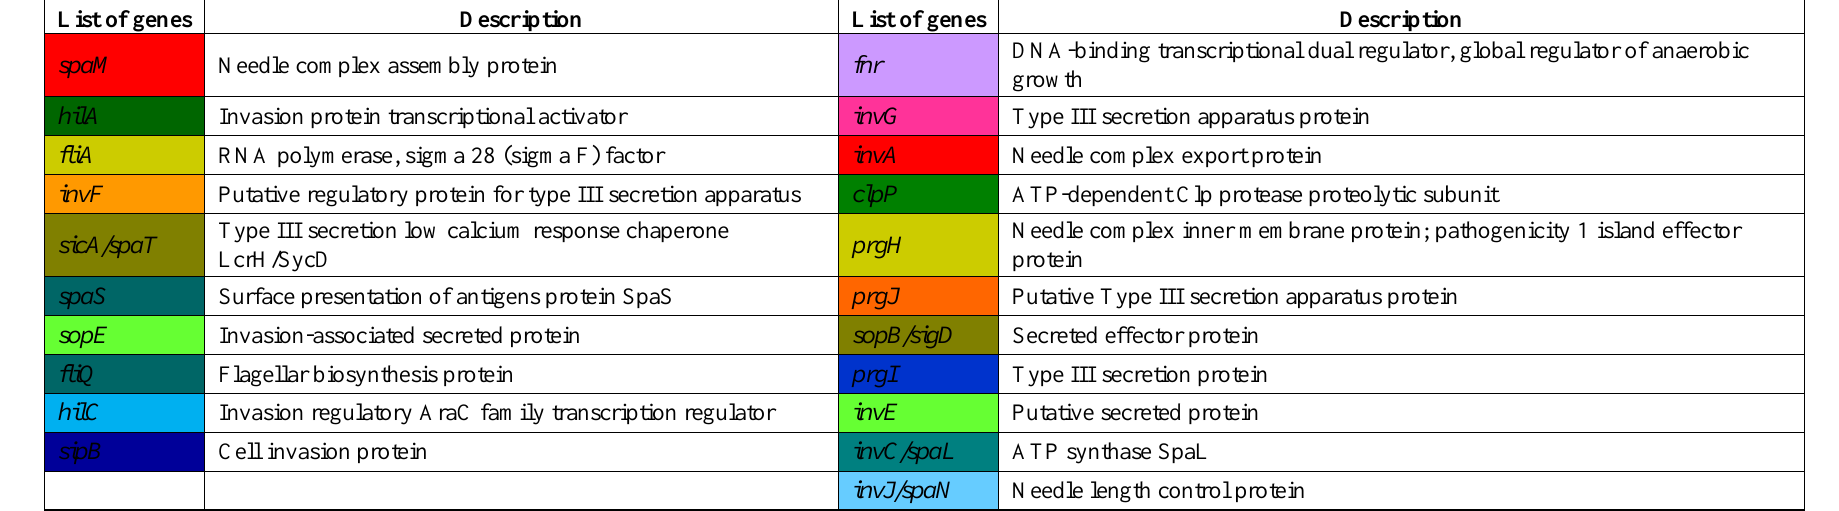
Table 5: Description for the genes in Figure 11a. The colour of gene corresponds to the colour of the line in the gene expression graph in SPI-1.